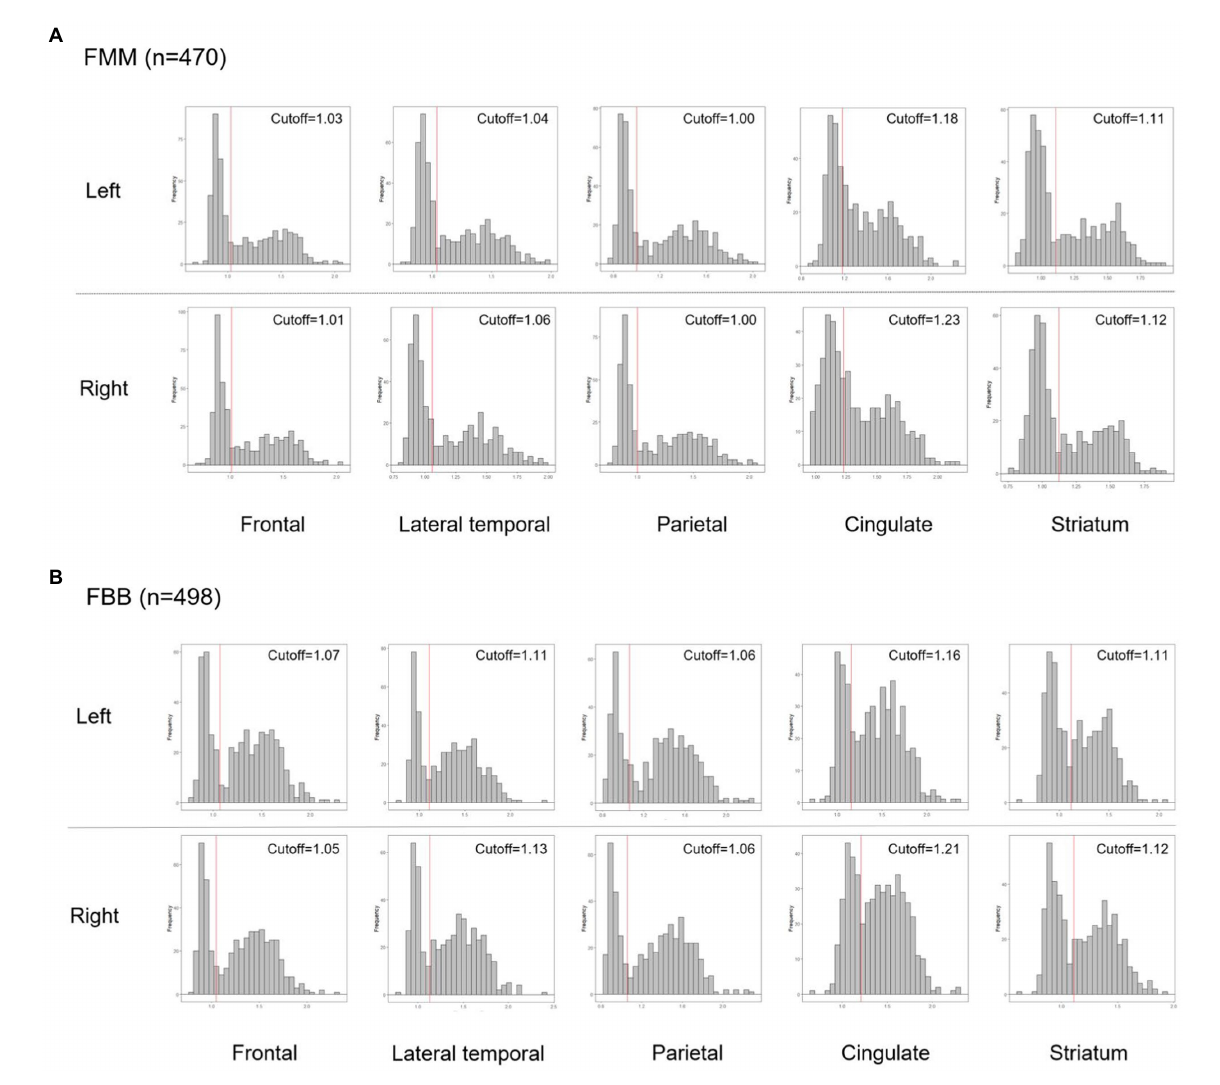
FIGURE 1 Histograms of the A β PET SUVR distribution in each A β ligand, FMM (A) , and FBB (B) for each region. Abbreviations: PET, positron emission tomography; FMM, Flutemetamol; FBB, Florbetaben; SUVR, standardized uptake value